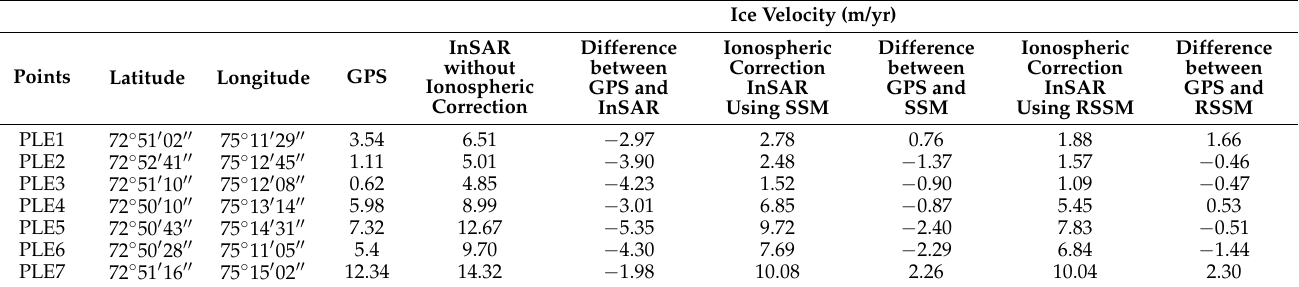
Table 3. Comparison between GPS measurements and ice velocity without ionospheric correction and with ionospheric correction using SSM and